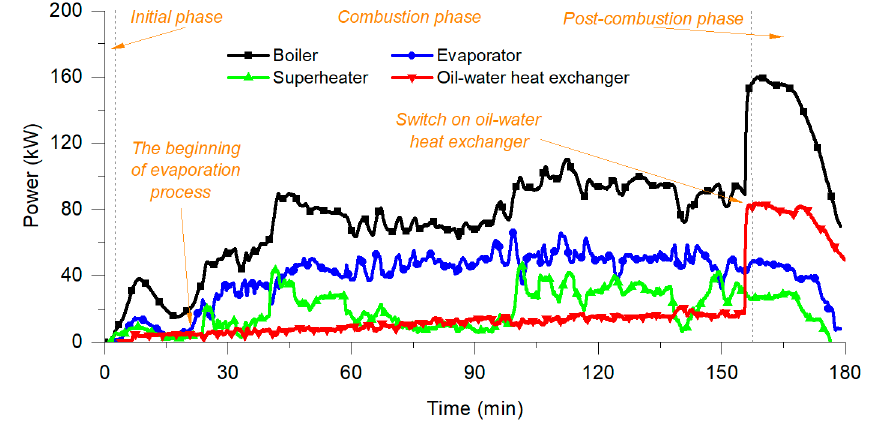
Figure 11. The variations in power transferred from oil to condensate, steam and water during the continuous combustion process.